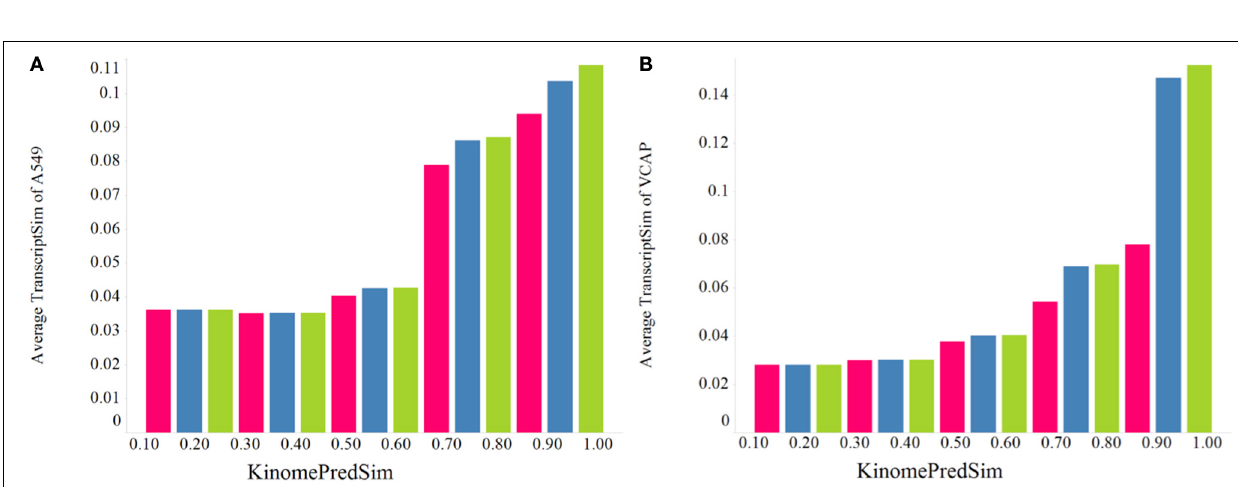
FIGURE 10 | Effect of the chemical similarity (ChemSim) of compound pairs on the trend of the average TranscriptSim as a function of KinomePredSim in (A) A549 cells and (B) VCAP cells. ChemSim cutoff